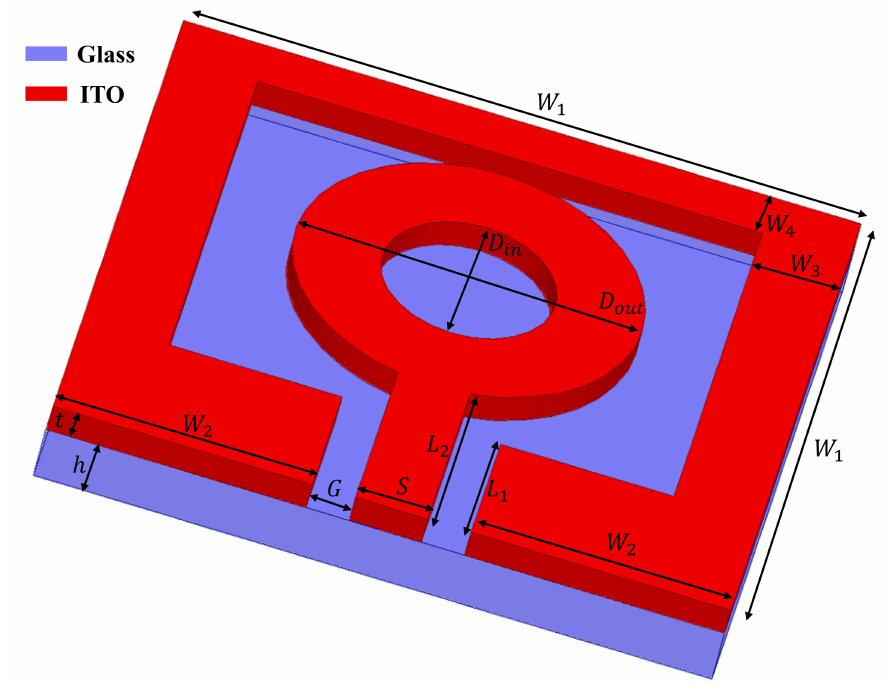
Figure 1. Three-dimensional geometry of the proposed optically transparent